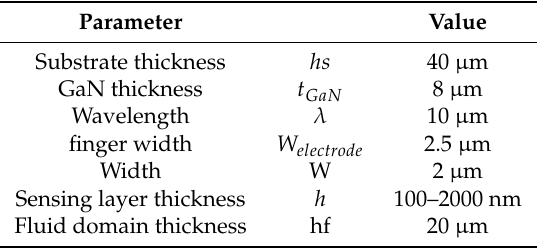
Figure 1. Schematic diagram of 3D model GaN/Sapphire used in FEM simulation with ( a ) guiding layer and with ( b ) the addition of fluid domain on top of guiding layer. Table 1. Geometrical parameters of the simulation model.